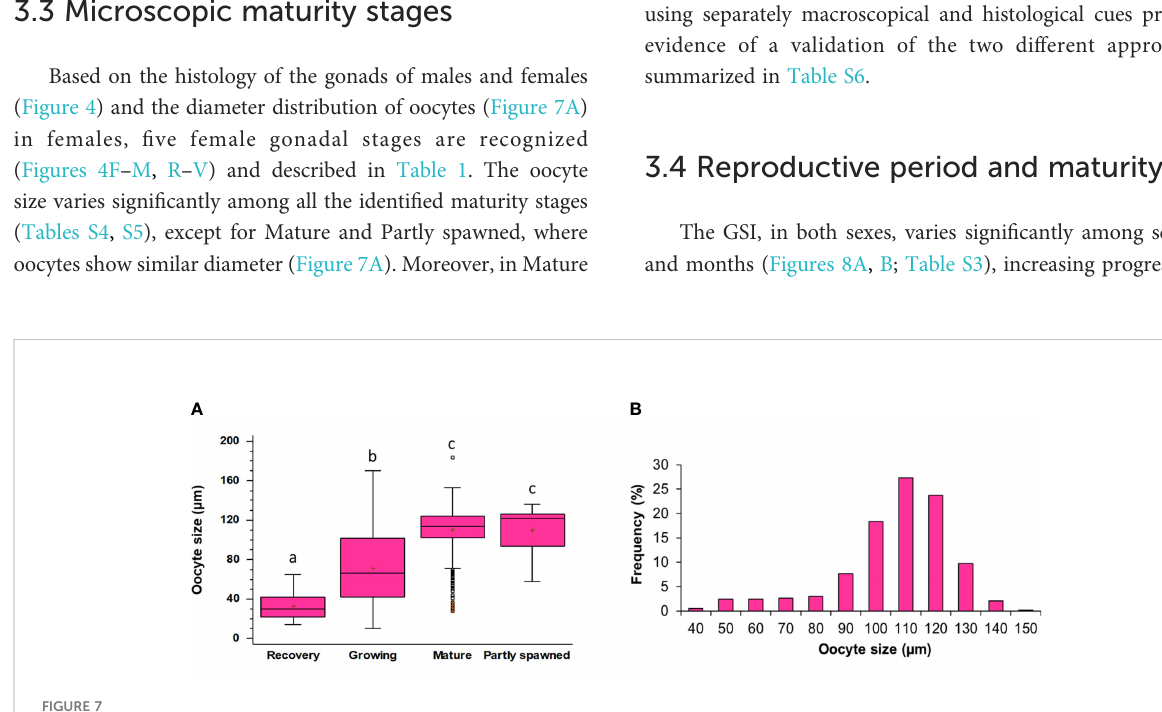
TABLE 1 Description of the microscopic gonadal stages in female and male of Holothuria tubulosa specimens. Stage Microscopic description Females Males Testes with thick gonadal wall (85.5 ± 25.5 µm). The germinal epithelium presented numerous folds that increased the surface area for spermatogenesis. Only spermatogonia are visible.